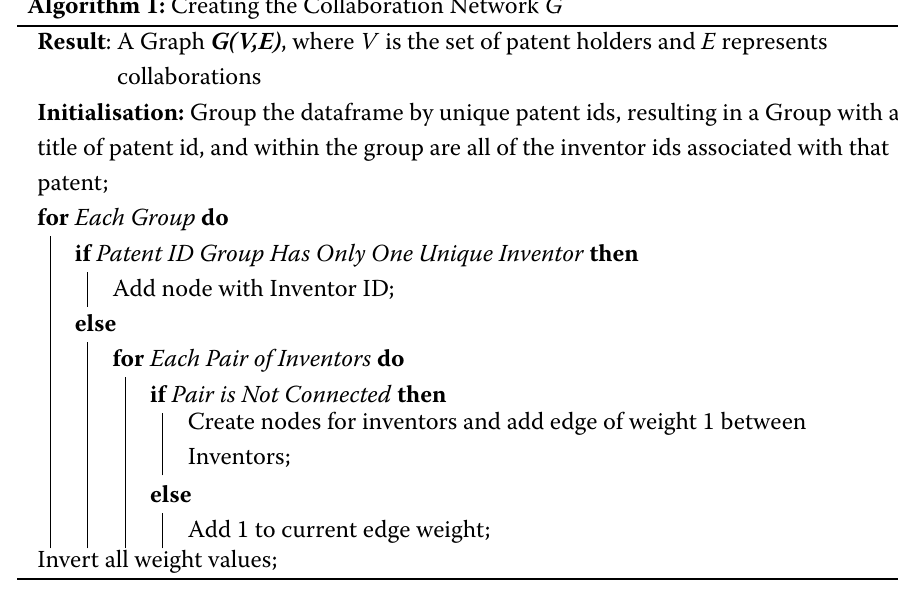
Algorithm 1: Creating the Collaboration Network